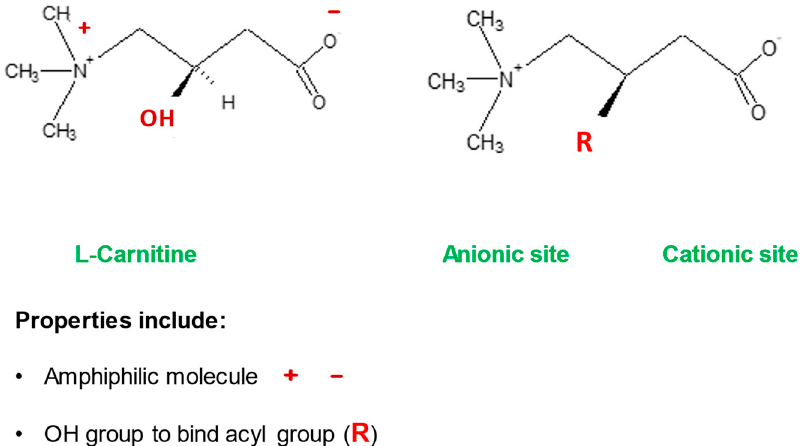
Figure 4. The amphiphilic nature of the L-carnitine molecule. Adapted from Virmani and Binienda, 2004 [20]. The unique amphiphilic nature of L-carnitine is attributed to the charges on its carboxyl and amine groups. The hydroxyl group gives it the ability to bind to fatty acids.